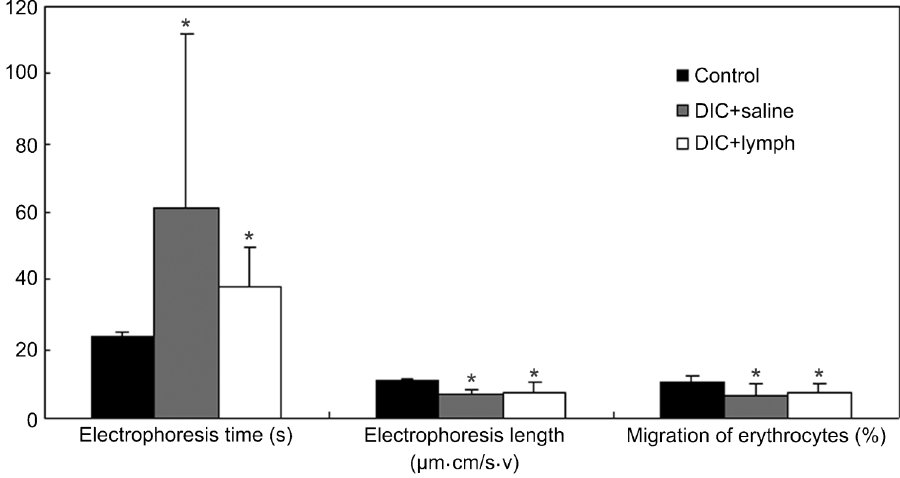
Figure 8. Changes of the electrophoretic properties of erythrocytes in the three rat groups studied. Data are reported as means ± SD for 10 rats. *P , 0.05 compared to the control group (one-way